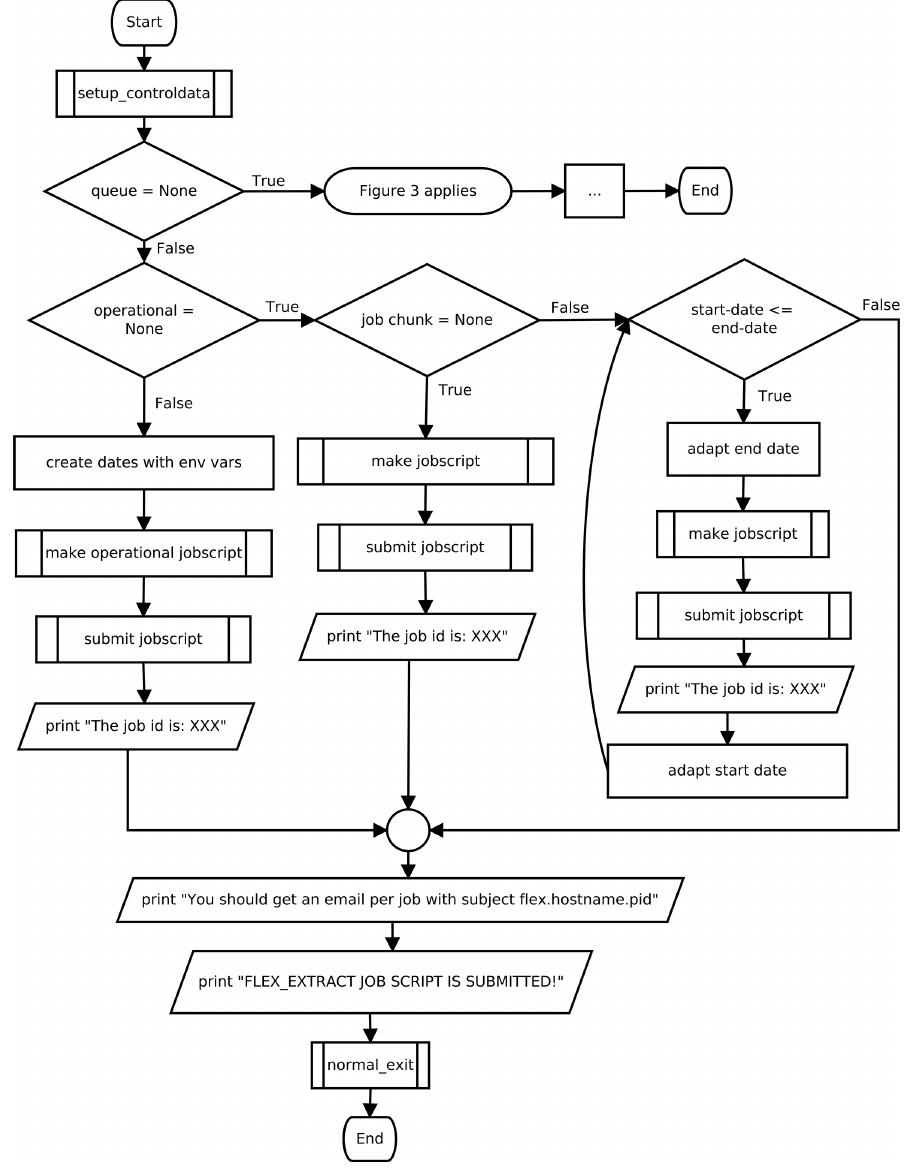
Figure 2. Flow diagram for the remote and gateway mode. A job script is created and submitted to the batch queue on an ECMWF server. The job script will then be executed on the ECMWF server to start flex_extract again for retrieving and post-processing of the data. The branch indicated by queue = None refers to the workflow shown in Fig. 3. Trapezoidal boxes mark standard output, simple rectangles mark the execution of sequential instructions, and the rectangles with a side border mark the execution of subroutines. The boxes in diamond form indicate decisions. Table 9. Description of the parameters stored in file ECMWF_ENV